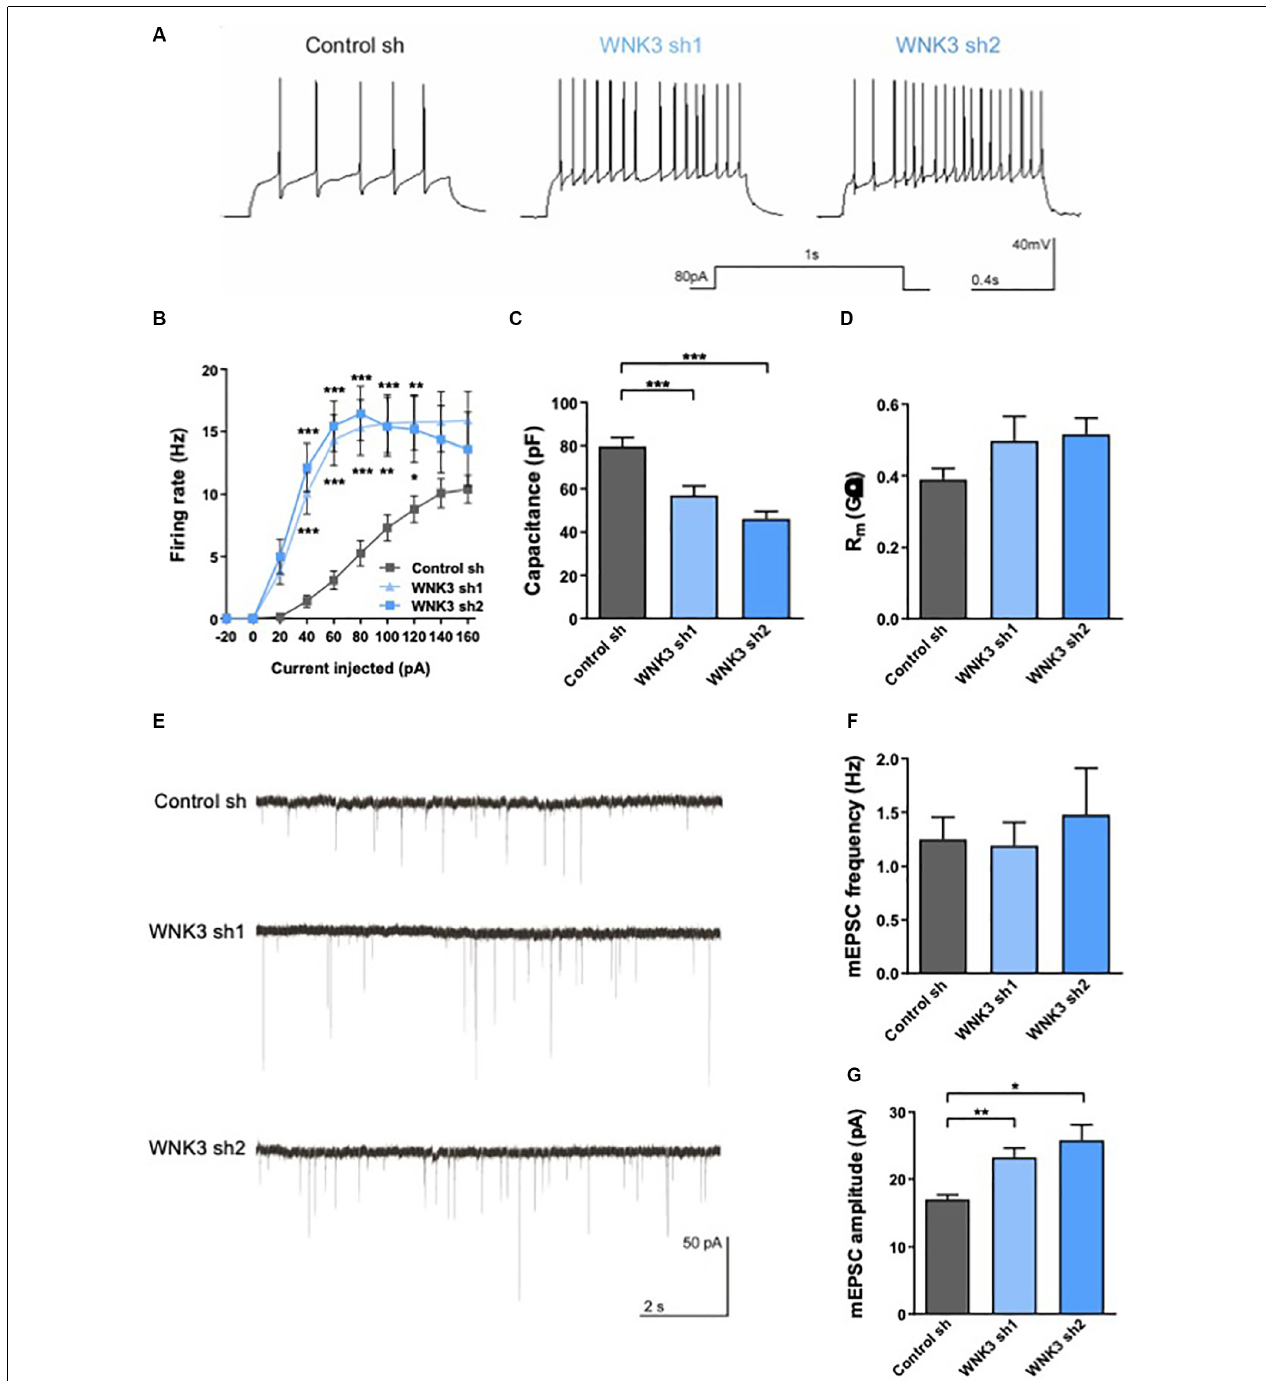
FIGURE 5 | Electrophysiological characterization of WNK3 knockdown in cultured hippocampal neurons (A) action potentials (AP) recorded in control sh, WNK3 sh1 and sh2 neurons. (B) Input-output curves generated by plotting AP firing frequency response to current injection control sh: n = 38 neurons, WNK3 sh1: n = 28 neurons and WNK3 sh2: n = 25 neurons. * p < 0.05, ** p < 0.01, *** p < 0.001 compared to control sh. Repeated-measure ANOVA with Bonferroni post-hoc . (C,D) Summary graphs of membrane properties of control sh ( n = 38 neurons), WNK3 sh1 ( n = 28 neurons) and WNK3 sh2 ( n = 25 neurons) recorded in whole-cell patch clamp, including membrane capacitance (C) and membrane resistance (D) , *** p < 0.001 compared to control sh, One-way ANOVA with Bonferroni post-hoc . (E) Representative miniature excitatory postsynaptic current (mEPSC) recordings from control sh ( n = 26 neurons), WNK3 sh1 ( n = 19 neurons) and WNK3 sh2 ( n = 5 neurons) DIV 14 hippocampal. (F,G) Graphs show mean mEPSC frequency (F) and amplitude (G) . ** p < 0.01 and *** p < 0.001 compared to control sh. One-way ANOVA with Bonferroni post-hoc .